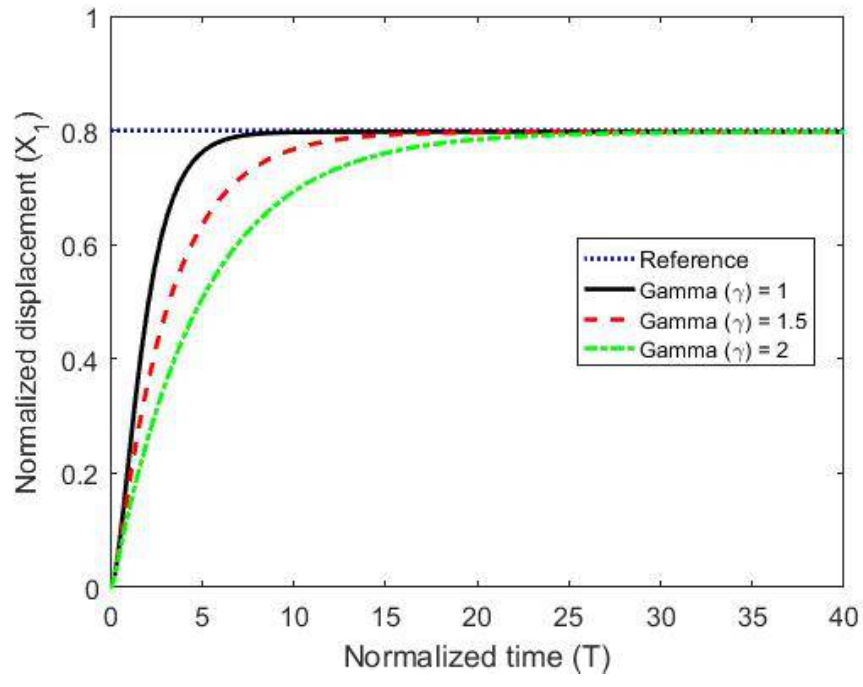
Figure 9. The normalized displacement with a different coupling term at a gap reference of 0.8.